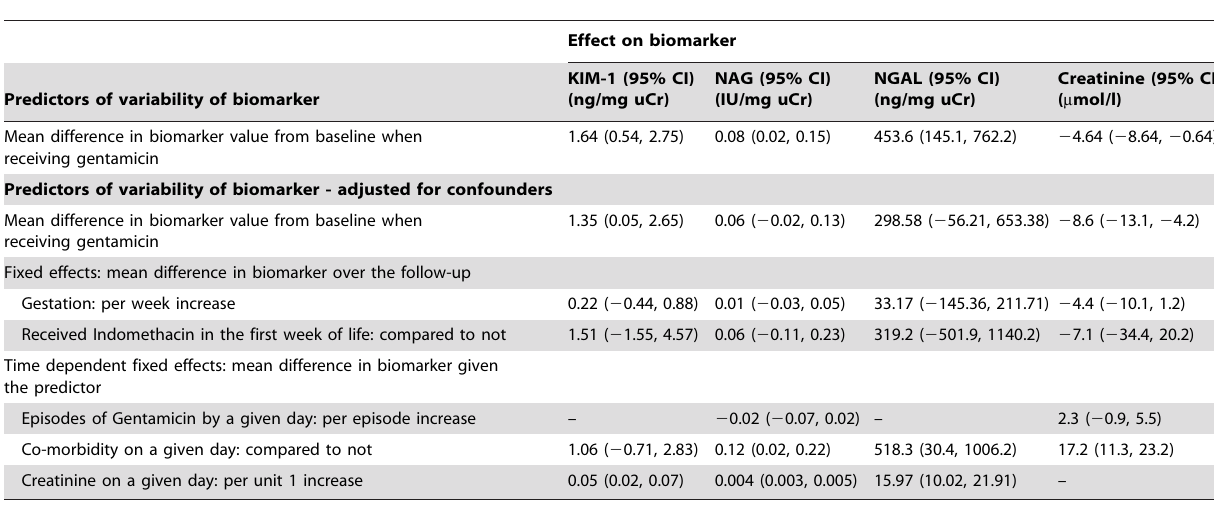
Table 2. Association between gentamicin treatment and the change in biomarker